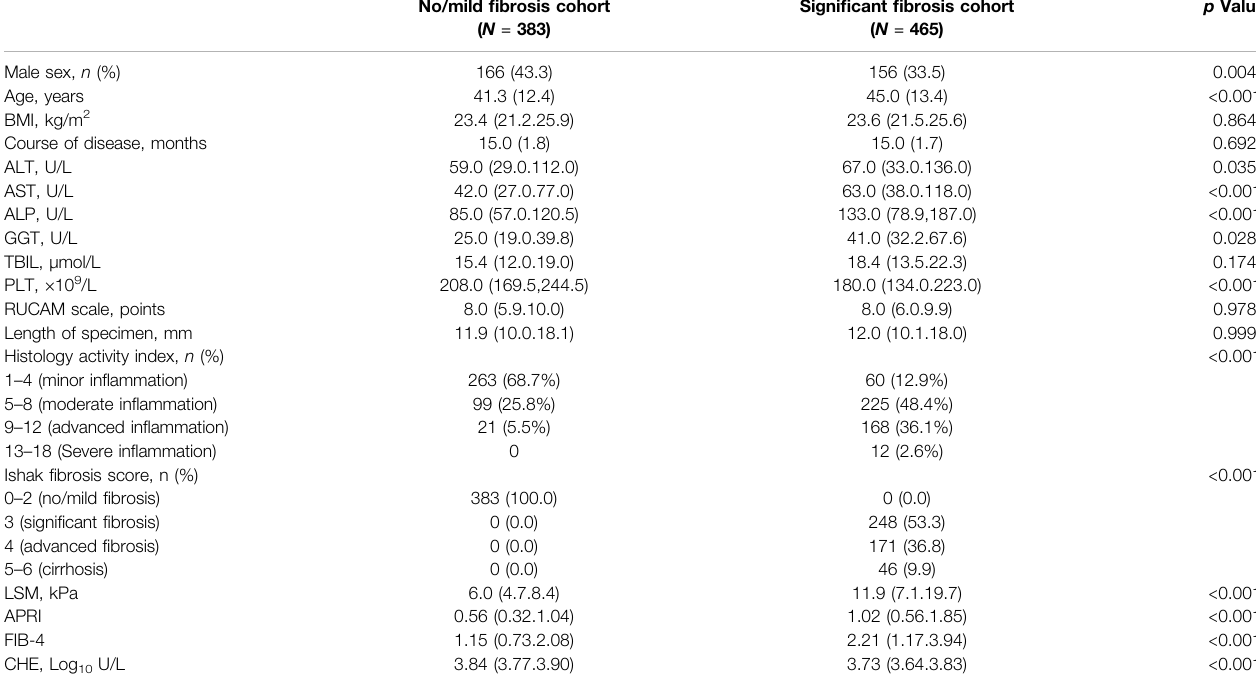
TABLE 1 | Characteristics of Patients with or without Signi fi cant Fibrosis in Training